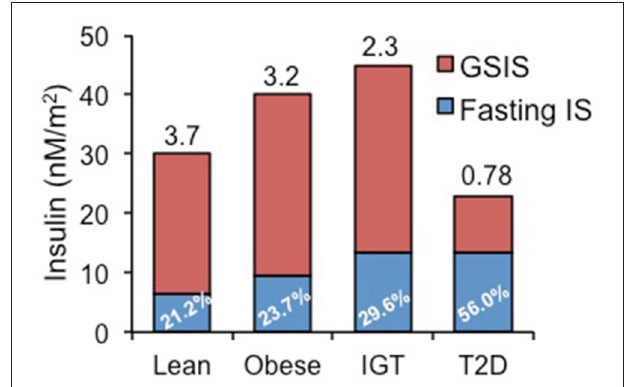
FIGURE 1 | Basal (fasting) and glucose-stimulated insulin secretion (GSIS) rates in lean, obese, patients with impaired glucose tolerance (IGT) and diabetics (T2D). Data redrawn from Ferrannini et al. (17), showing increasing percentage of basal insulin secretion rate relative to total insulin secretion rate and diminishing GSIS in IGT and T2D. Number above each bar represents the ratio of GSIS to basal insulin secretion rate.